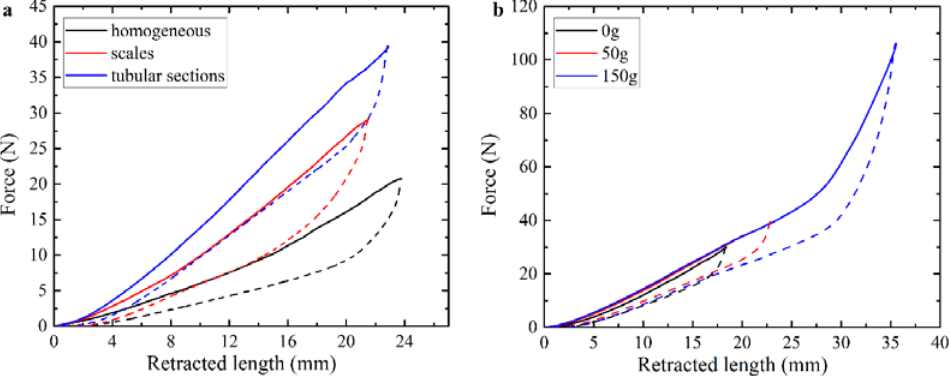
9 of 14 Figure 9. Experimental snapshot for TangoPlus actuators with periodic stiff inclusions (“scales”) ( a – c ) and stiff tubular sections around cable channel ( d – f ). 3.4. Sectioning of the Actuator Near Cable Channel Finally, we consider actuators with modifications of the channel surroundings. Remarkable mechanical performance is observed in the soft actuator with the central channel, which contains stiff cylindrical inserts around the void, splitting the actuator into three sections (Figure 2c). From the force-retraction curves (Figure 10a), it is obvious that due to the addition of the cylindrical inserts, which suppress local deformation near the channels walls, this actuator requires much higher force for deformation to occur. However, this particular structure allows us to obtain non-uniform bending